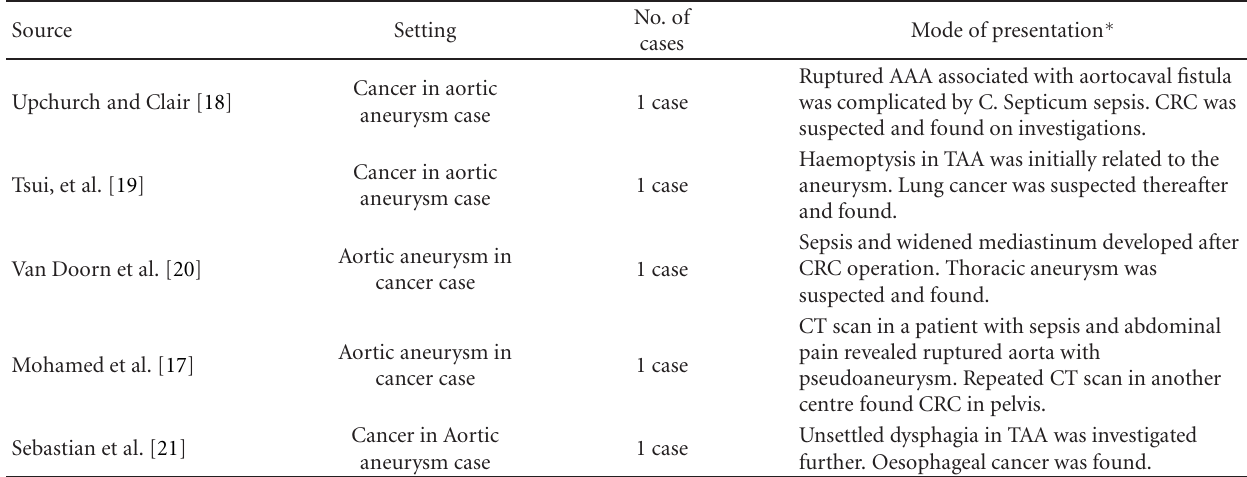
Table 2: Examples of clinical presentation of aortic aneurysm and/or associated